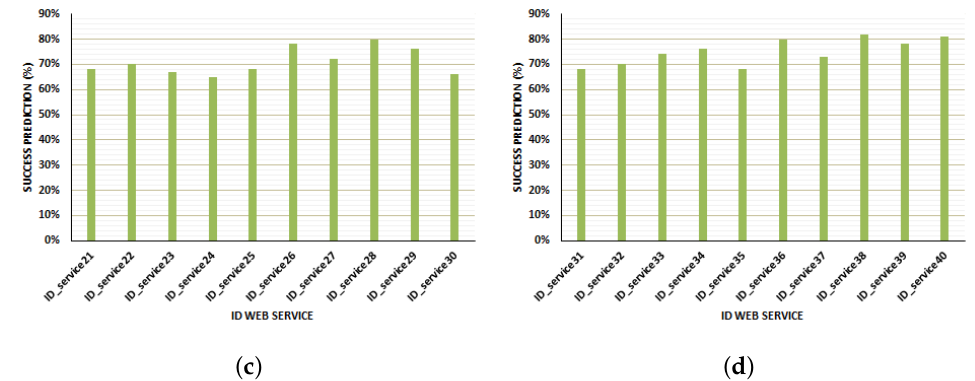
Figure 5. The prediction algorithm evaluation results in terms of success prediction ratio. ( a ) web service 1–10; ( b ) web service 11–20; ( c ) web service 21–30; ( d ) web service 31–40.